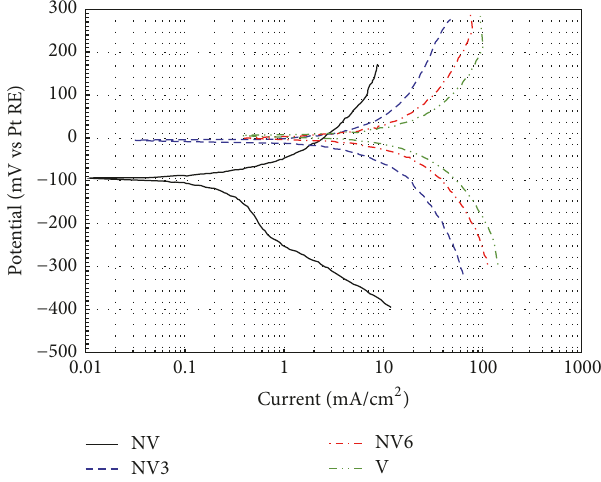
Figure 2: Potentiodynamic polarization curves for Ni in NV, NV3, NV6, and V at 800 ∘ C.